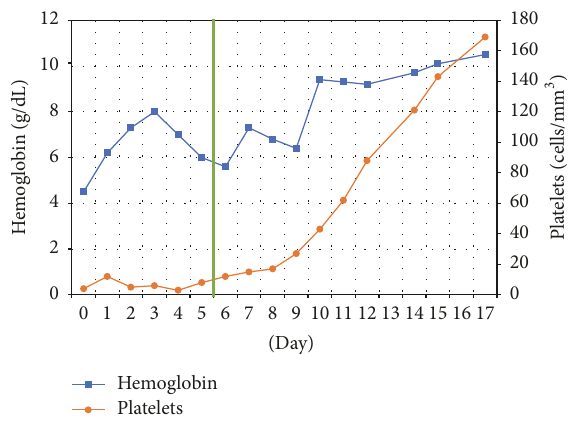
Figure 1: Timeline of hematological response. Vertical line repre- sents initiation of